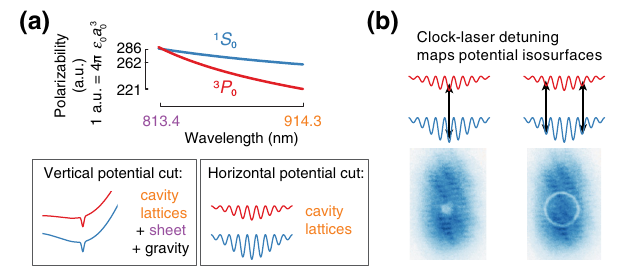
FIG. 3. Spatially dependent clock spectroscopy in nonmagic lattices. (a) The dynamic dipole polarizabilities of the g and e states (top). At the light sheet wavelength of 813.4 nm, g and e have the same polarizability (the magic condition). In contrast, at the cavity-lattice wavelength of 914.3 nm, e experiences a polarizability reduced by 15% compared to g (the nonmagic con- dition). For this reason, the light sheet creates identical traps for g and e , while the cavity beams create a slightly stronger potential for g than for e . Vertical and horizontal cuts through the trapping potential created by the light sheet and cavity lattice are sketched below (the polarizability difference between g and e is exagger- ated for a clear illustration). (b) In situ absorption images after probing the clock transition at different detunings indicated by the black arrows. The differential ac Stark shifts of the nonmagic cavity lattices allow local addressing, leading to ring structures that map the lattice